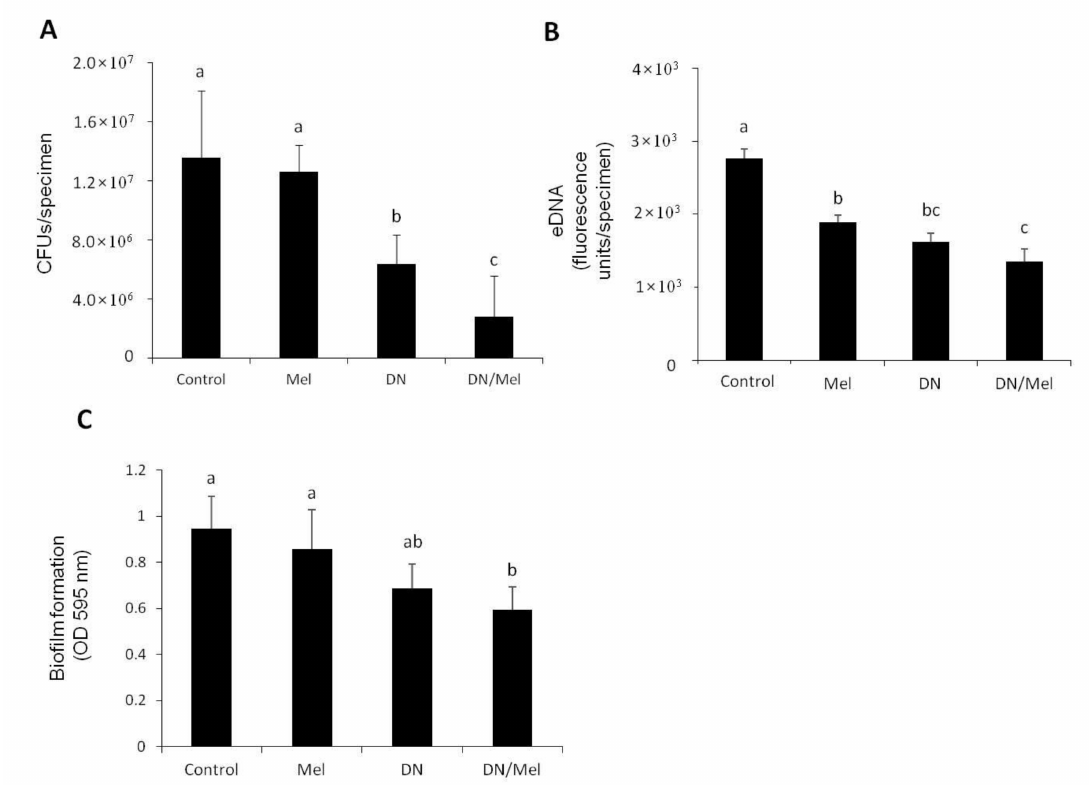
Figure 1. Evaluation of the antibacterial activity of melittin against E. faecalis biofilms. ( A ) Colony forming unit (CFU) counting. ( B ) eDNA measurement of E. faecalis biofilm. ( C ) Biofilm